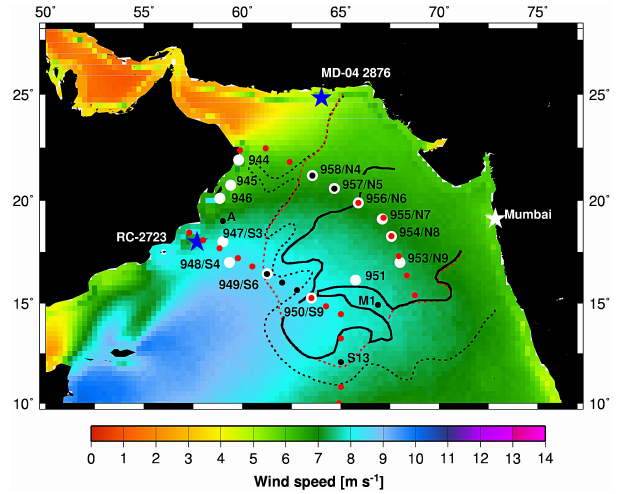
Figure 1. Mean SW monsoon winds speeds over the Arabian Sea. The area of enhanced wind speeds indicates the Findlater Jet. The black lines were redrawn from Naqvi and Shailaja (1996) and show the expansion of the area in which NO − concentrations within 2 the SNM were > 0.5µmolkg − 1 (broken line) and > 2µmolkg − 1 (solid line). Circles represent the stations covered during the US JGOFS expeditions in 1995 (red and black) and the RV Meteor cruise M74/1b in 2007 (white). The M74 stations are indicated by the numbers 944–958 and the US JGOFS station numbers are A, M1, S(1–13), and N(1–11). The station at which nitrite concen- trations > 2µmolkg − 1 were observed outside the area marked by Naqvi and Shailaja (1996) in 1995 are indicated by the black cir- cles. Based on these stations and the former 0.5µmolkg − 1 line, the expansion of the area in which NO − concentrations within the 2 SNM were > 2µmolkg − 1 in 1995 was drawn (red broken line). The blue stars indicate the location of the sediment cores MD-04 2876 (Pichevin et al., 2007) and RC-2723 (Altabet et al.,